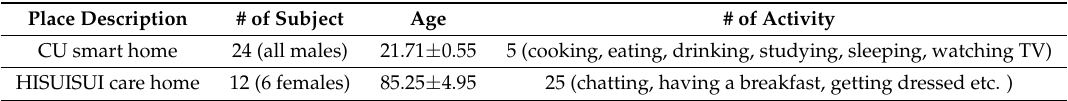
Table 2. The dataset description.